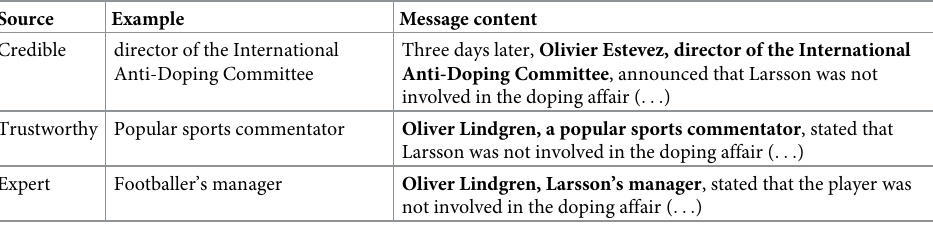
Table 1. Examples of the sources (in Football affair scenario �